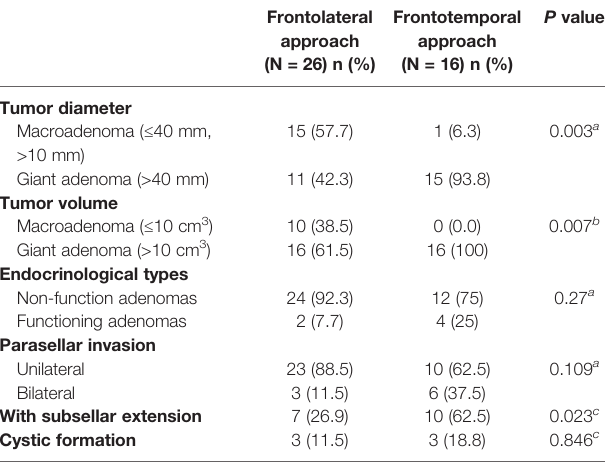
TABLE 4 | Surgical approach based on preoperative imaging characteristic.